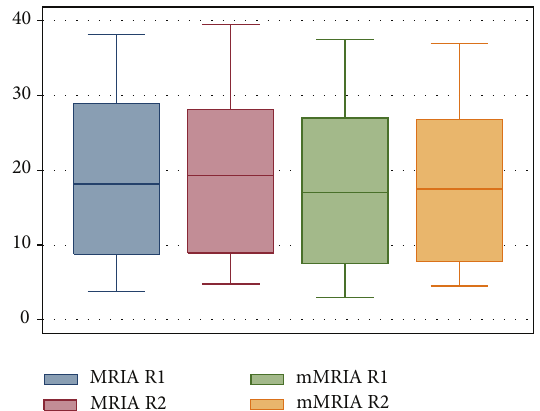
Table 3: Disease activity of patients’ series according to SES values. SES group Number of patients Disease in remission 3 Mild disease activity 27